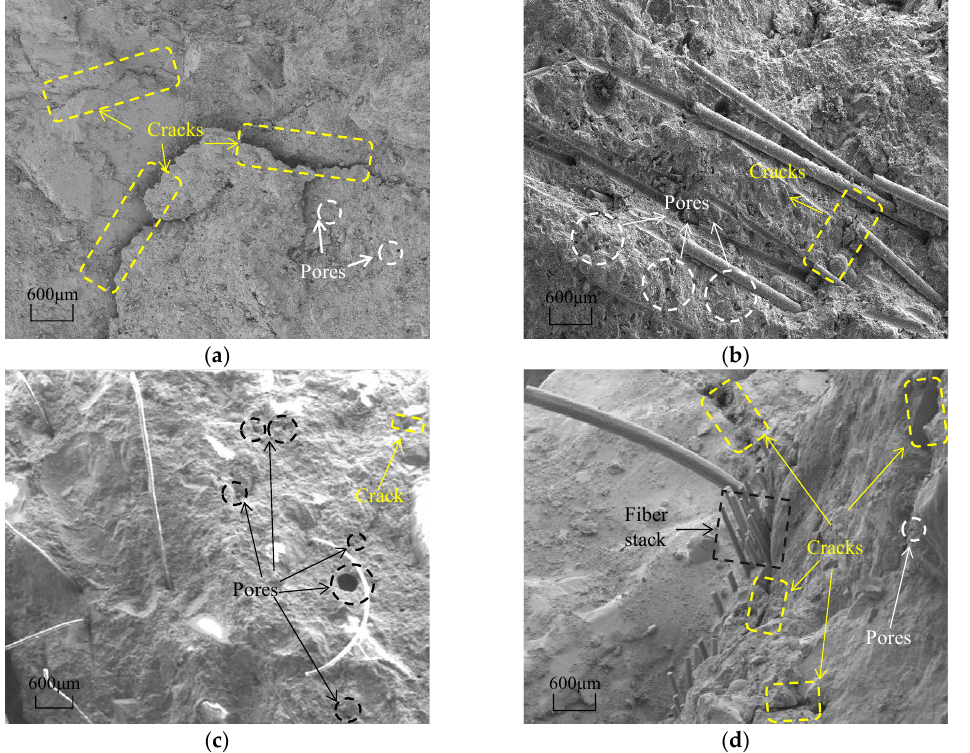
Figure 4. SEM diagram of specimens: ( a ) NC-30; ( b ) BF-30-0.1; ( c ) PF-30-0.1; ( d ) HF-30-0.2.